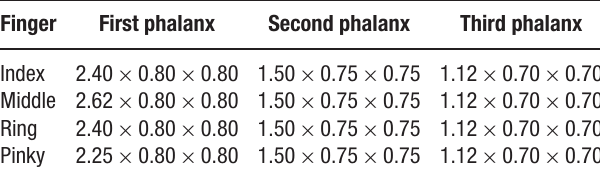
Table 1 . The size (in cm) of the segments forming the